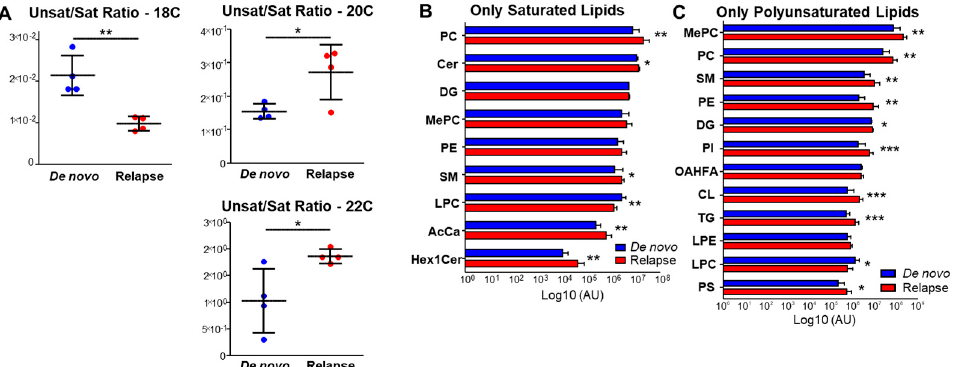
Figure 3. Relapsed LSCs display aberrant fatty acid desaturation. ( A ) Ratio of free fatty acids containing one or more desaturations to fully saturated free fatty acids, for free fatty acids containing 18, 20, and 22 carbons, in paired de novo and relapse patient 3. ( B ) Total levels of lipids containing only saturated fatty acids in de novo and relapsed AML LSCs. (de novo patients 1, 2, and 3 and relapsed patients 1, 2, and 3). ( C ) Total levels of lipids containing only unsaturated fatty acids in de novo and relapsed AML LSCs. (de novo patients 1, 2, and 3 and relapsed patients 1, 2, and 3). * p ≤ 0.05, ** p ≤ 0.01, *** p ≤ 0.001.